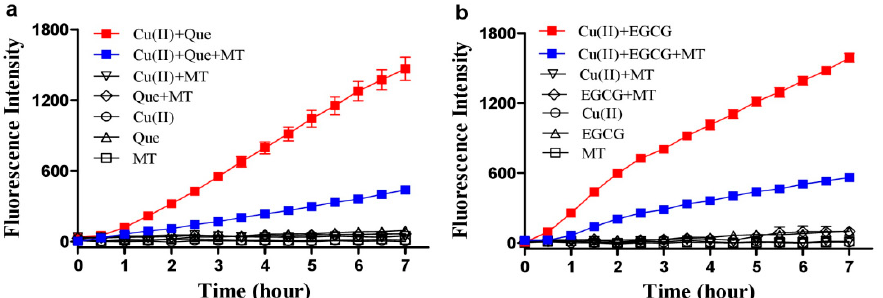
Figure 7. Melatonin inhibits hydroxyl radical formation by copper and quercetin or EGCG. ( a ) Melatonin inhibited the synergistic production of •OH by quercetin (Que) and Cu(II). ( b ) Melatonin